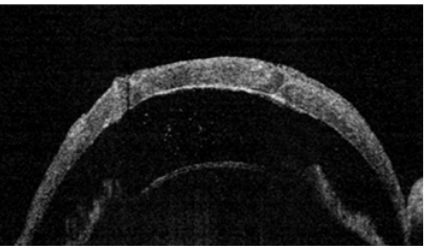
Figure 6: An AS-OCT image demonstrating anterior chamber inflammation in a rejected graft in a rat